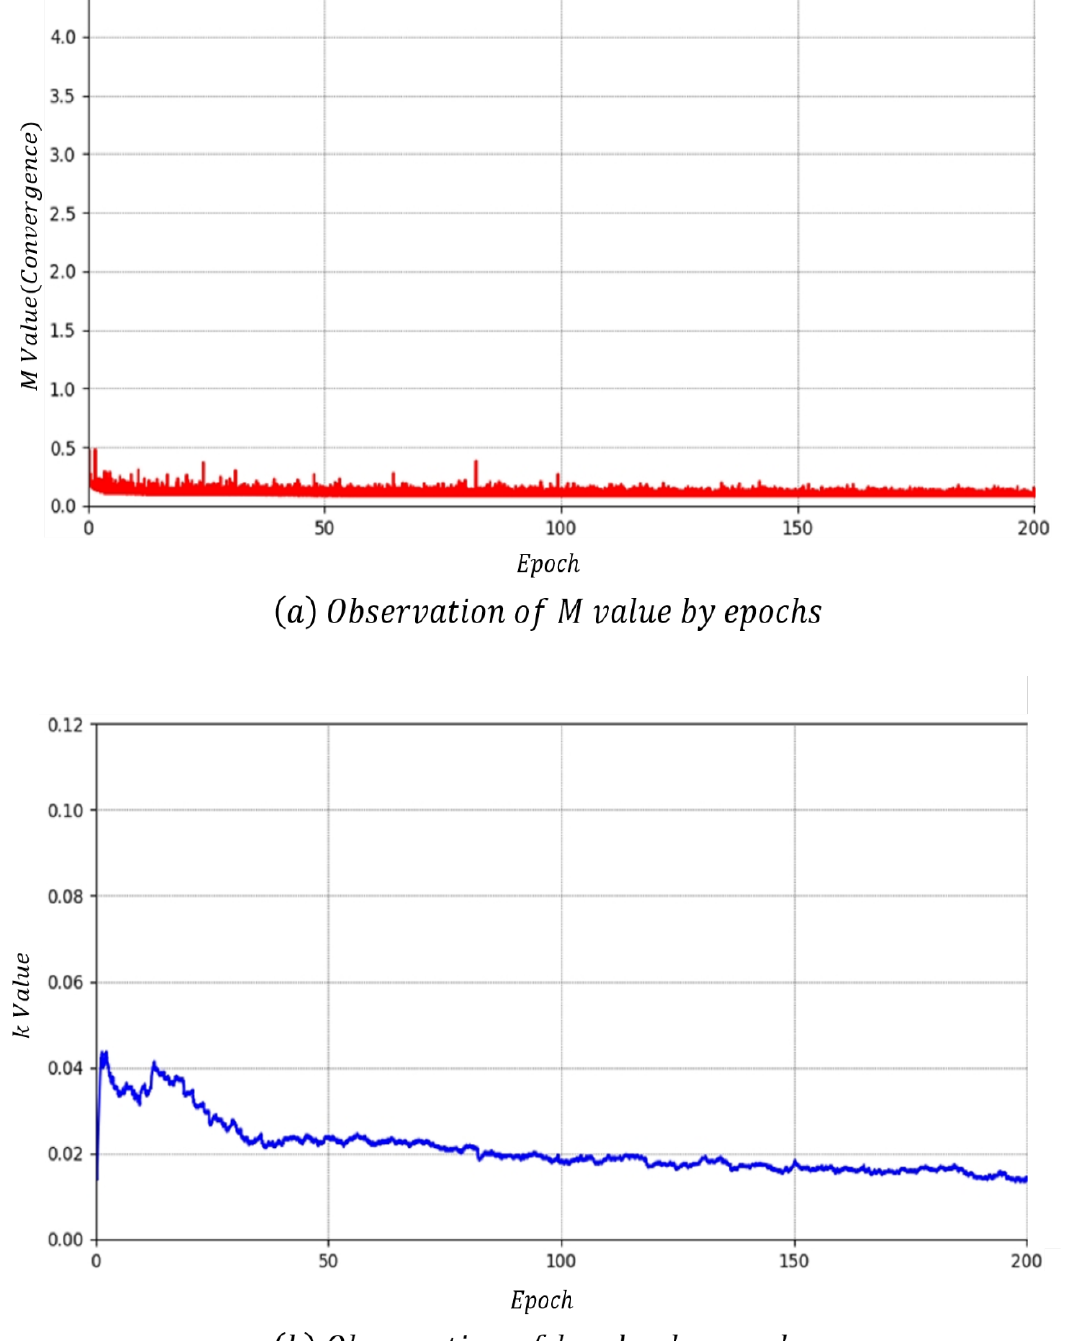
Figure A5. Results of convergence measurement for the CelebA dataset.